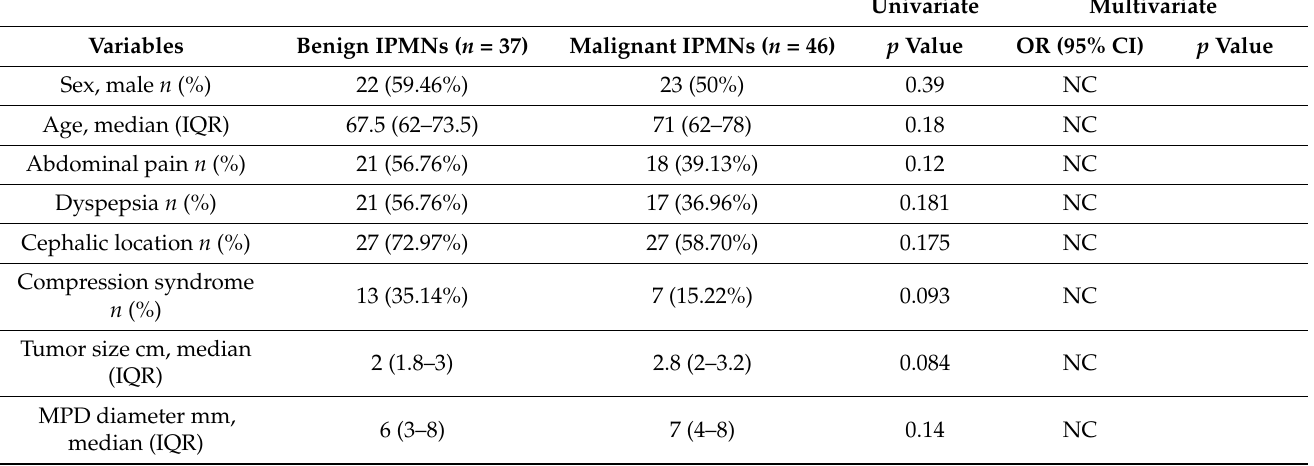
Table 2. Clinicopathological features and biomarkers univariate and multivariate analysis for predicting malignant intraductal papillary mucinous neoplasm (IPMNs). Statistically significant values are in bold. OR: odds ratio; CI: confidence interval; NC: not calculated; IQR: interquartile range; MPD: main pancreatic duct; mGps: modified Glasgow prognostic score; NLR: neutrophil-to-lymphocyte ratio; PLR: platelet-to-lymphocyte ratio; CAR: C-reactive protein to albumin ratio; PNI: prognostic nutritional index.